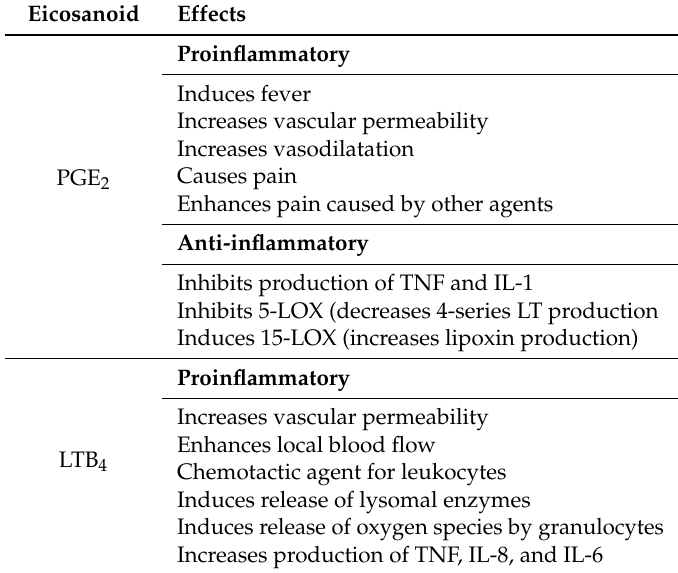
Table 2. Pro- and anti-inflammatory effects of prostaglandin E 2 (PGE 2 ) and leukotriene B 4 (LTB 4 ) 1 . Eicosanoid